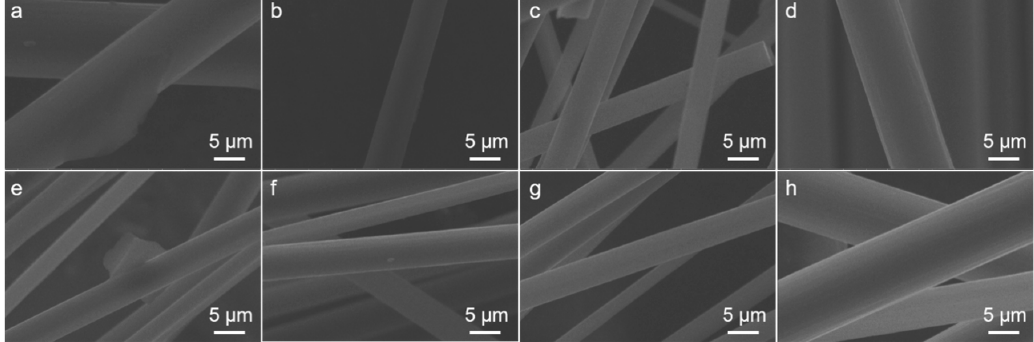
Figure 3. Scanning electron microscopy (SEM) images of the representative recycled carbon fibers.